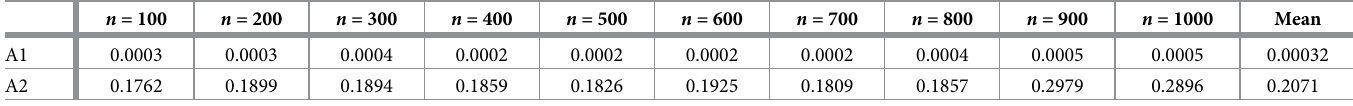
Table 1. Comparison of algorithm efficiency for solving (GCKP) (time unit: Second).